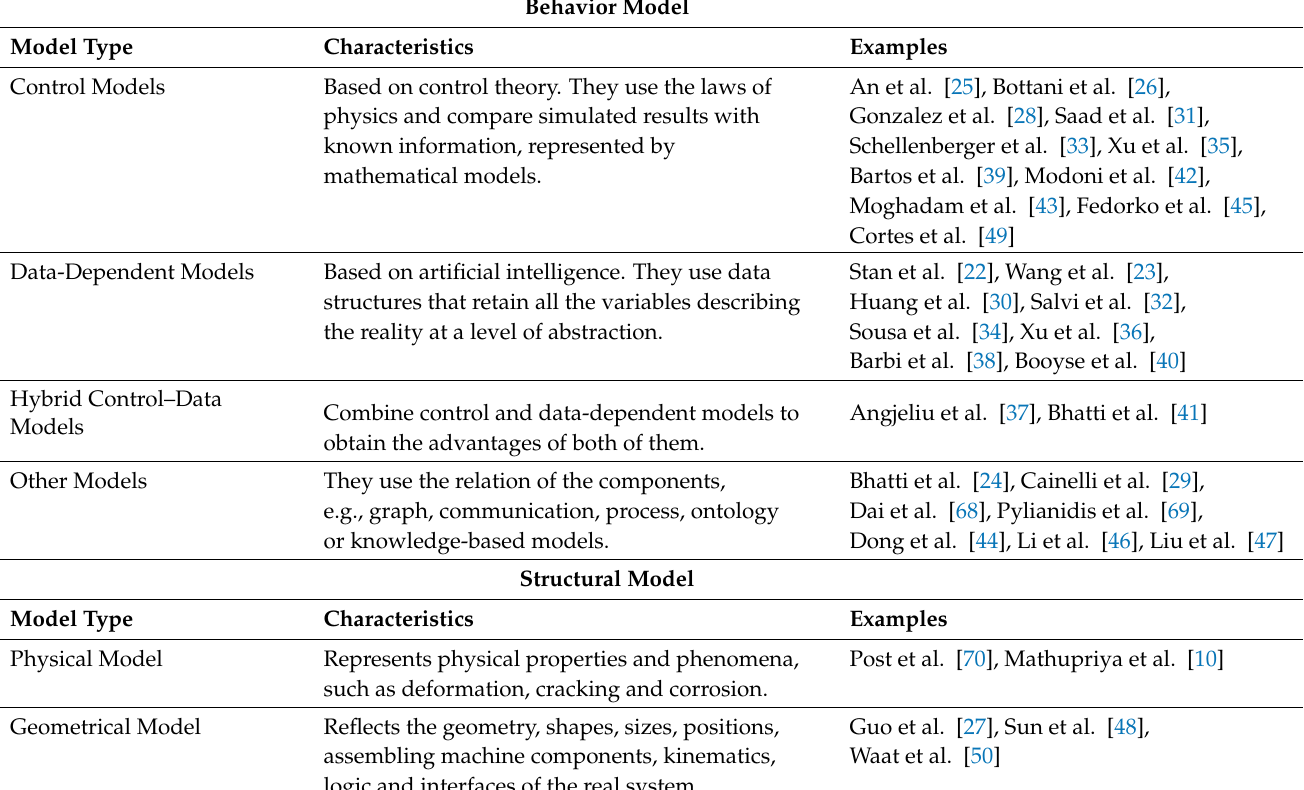
Table 2. Sample modeling